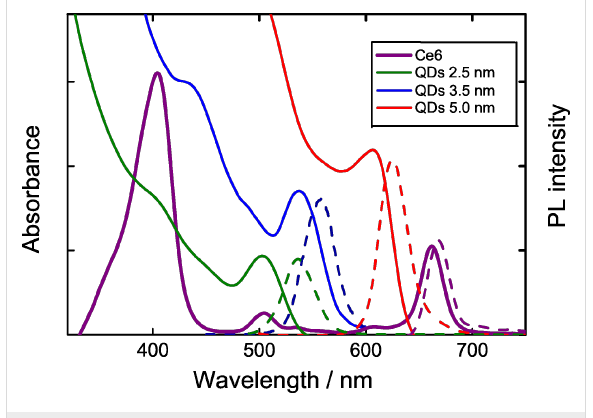
Figure 1: The absorption (solid line) and photoluminescence (dash line) spectra of QDs of different sizes and Ce6. The QD sizes are shown in the